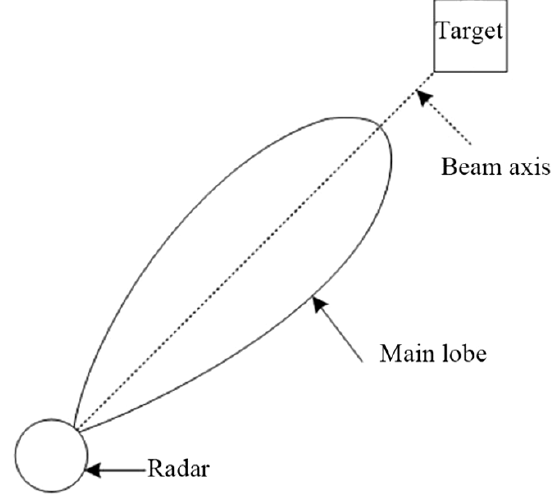
Fig. 1. Radar azimuth